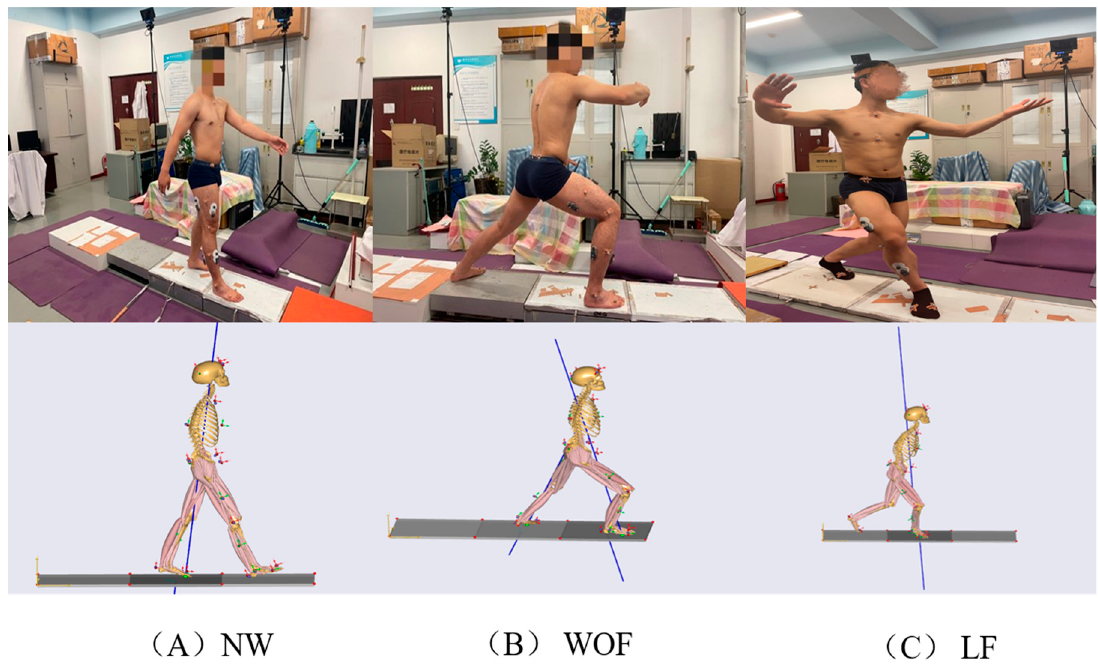
Figure 3. Musculoskeletal models of ( A ) NW, ( B ) WOF, ( C ) LF.